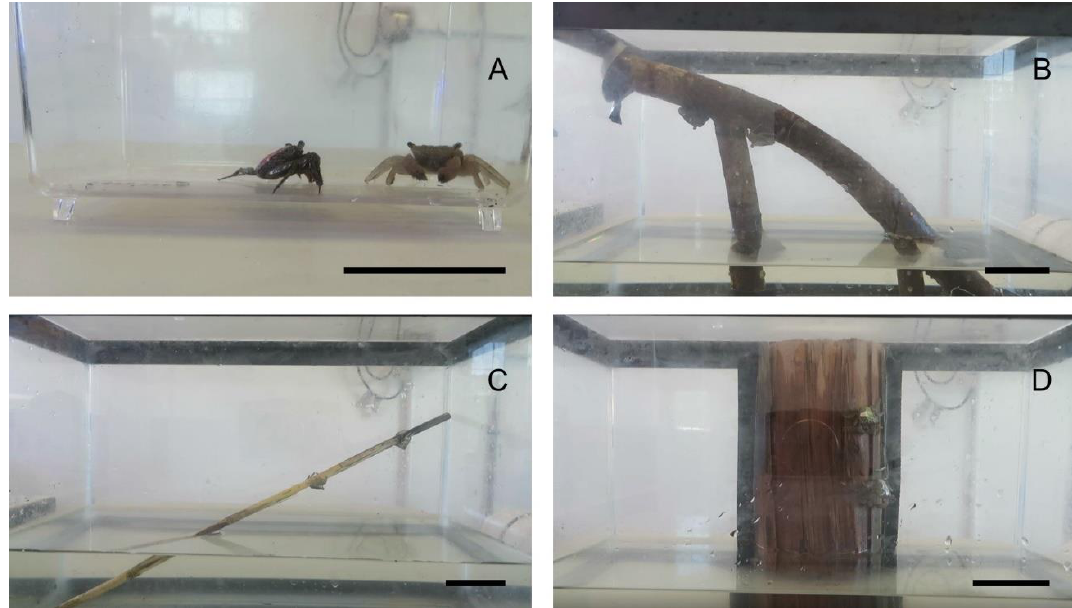
Figure 1. Representations of assays performed on ( A ) neutral structure, ( B ) mangrove structure, ( C ) salt marsh structure, and ( D ) dock structure. Scale bars represent 5 cm. Table 2. Ethogram of behaviors in the A. pisonii ritualized aggression progression. Adapted from [16].